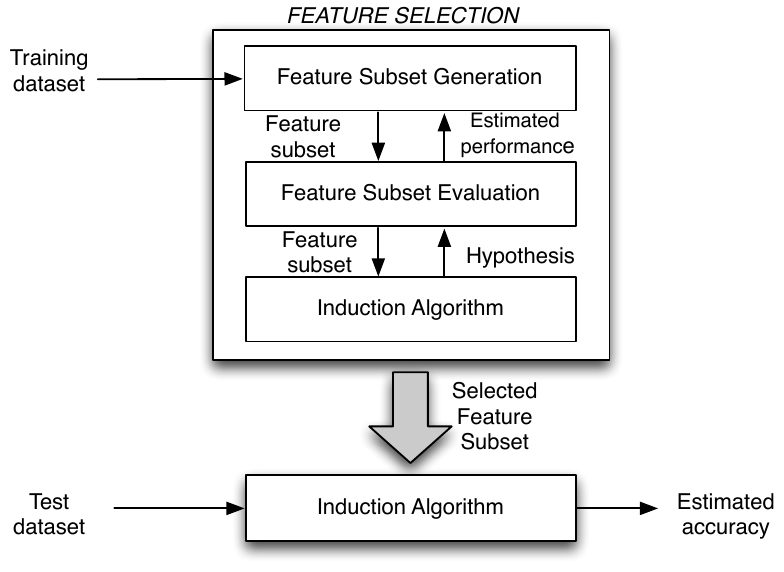
Figure 2. Wrapper approach